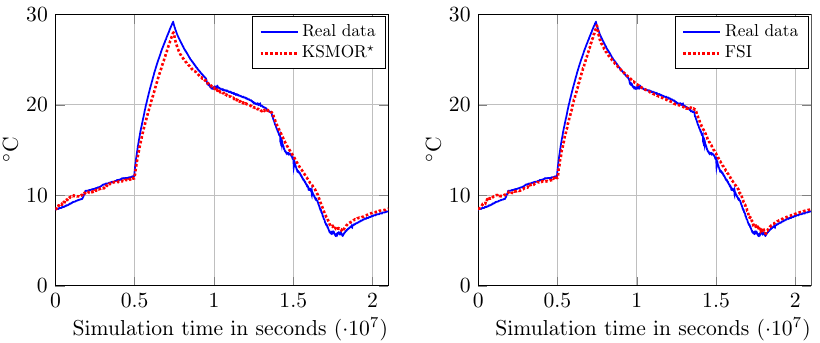
Figure 11. Results of the GES experiment for temperature probe B1 (3rd from the top): visual comparison (along the temporal axis) between the real temperature from 3D test field and the approximations of the 2D model computed by the proposed solvers. A special emphasis on this is that the results generated by FSI, direct CN and KSMOR (cid:63) cause CPU time of 10 s , whereas the EE scheme produces substantial costs of 69 s . The simulation time amounts to around 243 days and the grid size is fixed to h = 0.04 ( N = 100,701 grid points). Left top: EE for τ max,2D = 588.23 (35,839 iterations). Right top: Direct CN for τ = 44,854 (470 iterations). Left bottom: KSMOR (cid:63) with s = 10 and q = 2 for τ = 13,176 (1600 iterations). Right bottom: FSI for M = 220 cycles (4840 iterations). The EE method applied to the two-dimensional model problem reproduces a highly accurate approximation with regard to real data given from the three-dimensional test